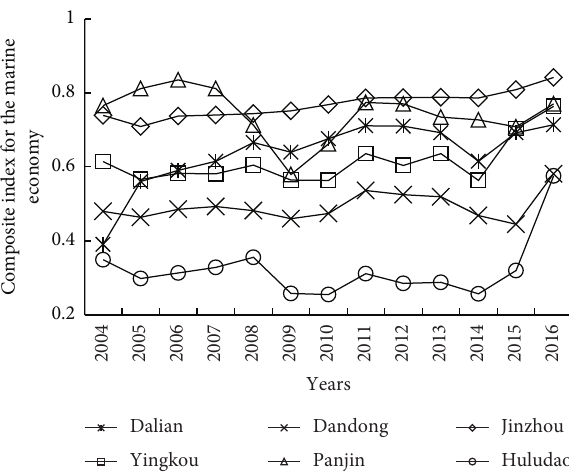
Figure 4: Composite index for the marine